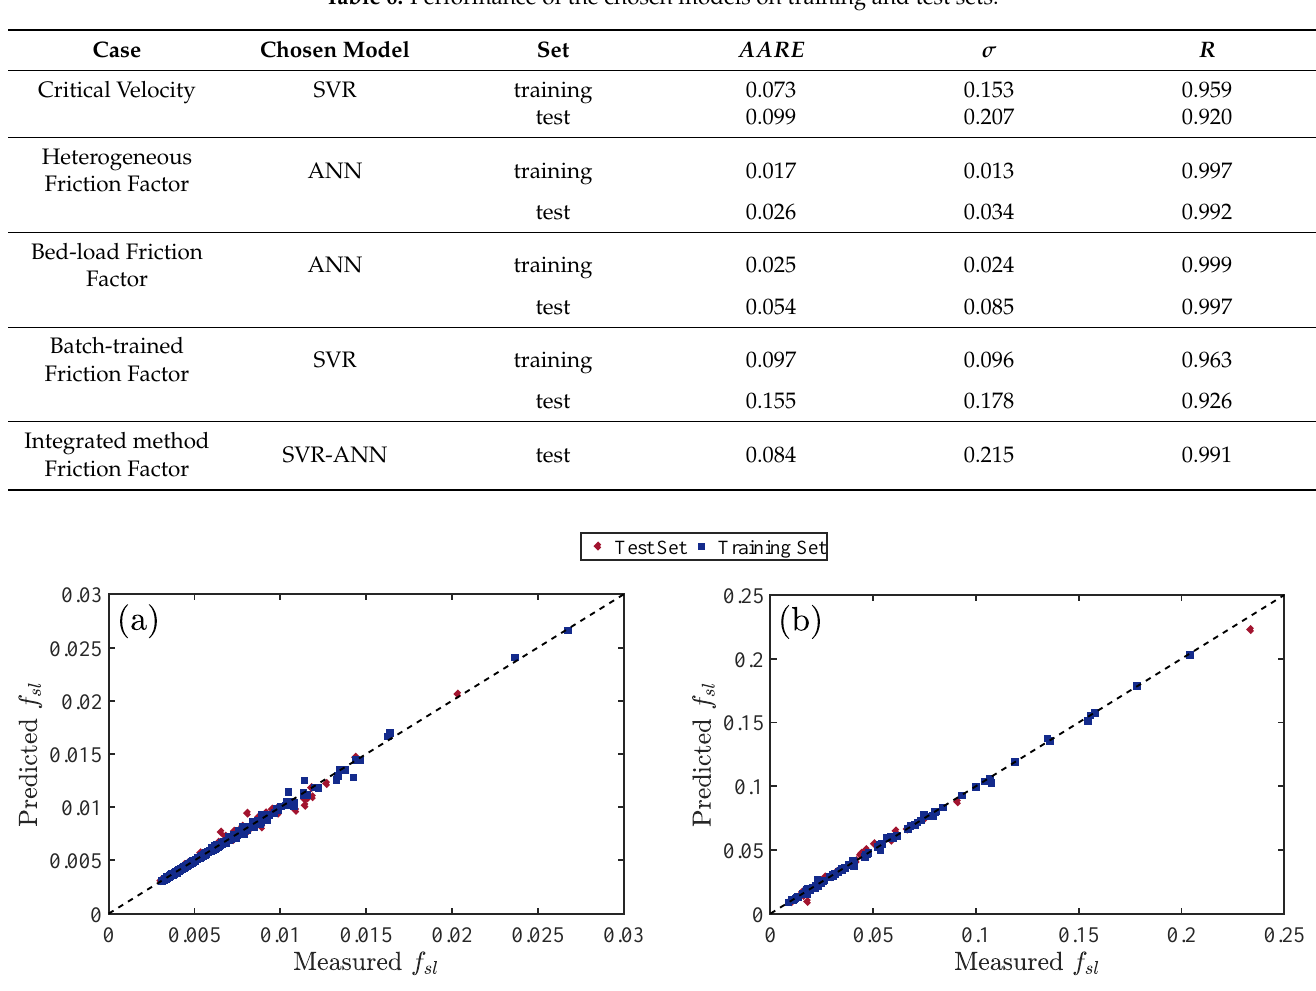
Table 6. Performance of the chosen models on training and test sets.